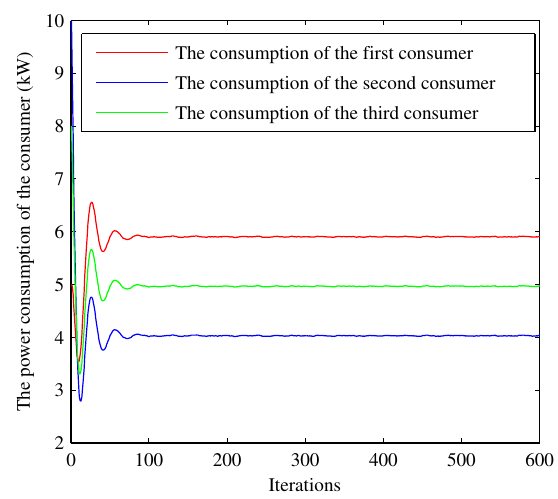
Figure 7. Convergence of the power consumption under case I.